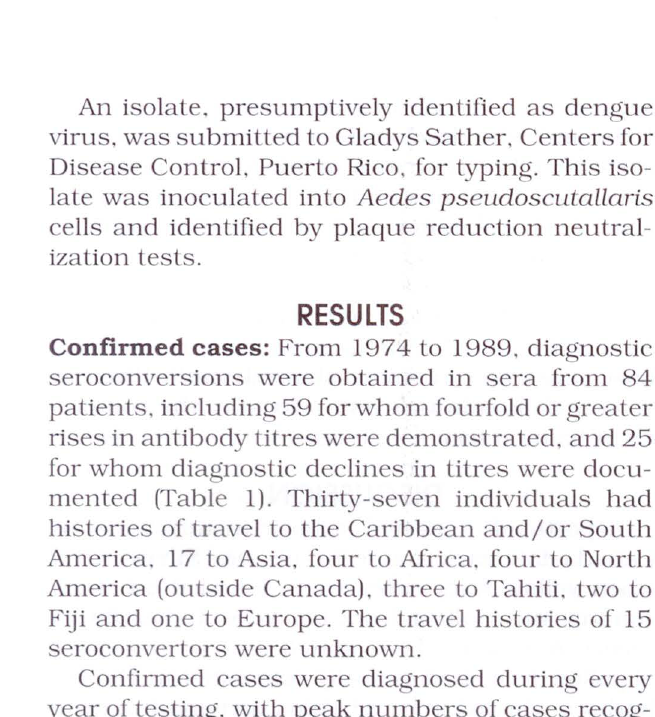
Representative serology of confirmed flavivirus serocon vertors likely infected with dengue virus